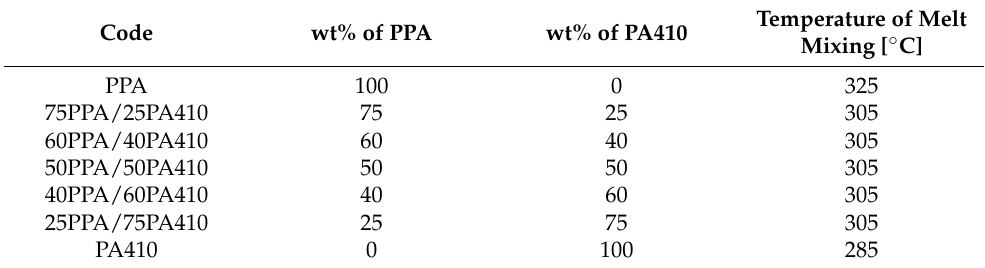
Table 1. Coding of produced blends and temperature employed to melt mix them.